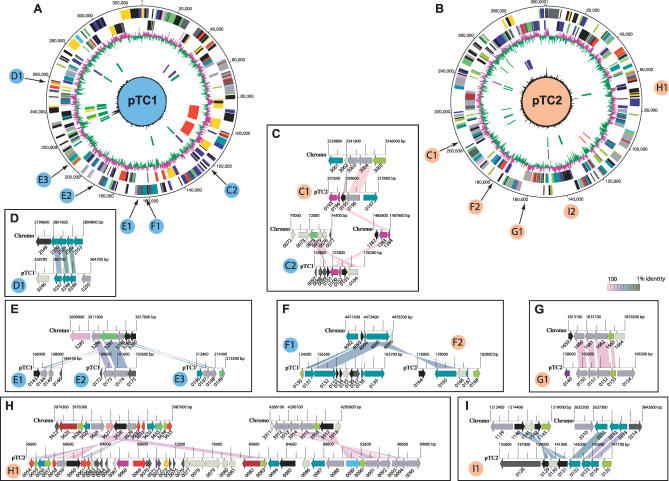
Circular Representations of the pTC1 and pTC2 Plasmids of A. aurescens TC1, and Comparative Linear Displays of Some of the Plasmid Regions Shared with the Strain TC1 Chromosome(A and B) Each concentric circle of the circular figures is numbered from the outermost circle to the innermost circle. For each plasmid, the first and second circles represent the predicted coding sequences on the plus and minus strands, respectively, colored by functional role categories (see Figure 1). The third circle displays the G + C skew: positive G + C skew in magenta and negative G + C skew in green. The fourth circle displays the repeated sequences of at least 50 bp long (at least 97% identity between two repeats); each color/tick size represents a different repeat. Prophage (blue ticks) and transposon (dark green ticks) genes are displayed on the fifth circle. The sixth circle shows the regions of atypical composition (χ2 analysis).(C–I) Comparative linear displays of some of the pTC1 and pTC2 sequences matching the TC1 chromosome. The percent of protein identity is indicated by the color of the connecting lines (legend on the right side of the figure). For clarity, the locus tags (AAur_ for the chromosome, and AAur_pTC1 and AAur_pTC2 for the pTC1 and pTC2 plasmids, respectively) were removed from the ORF numbers. For example, the chromosomal ORF number 2549 is AAur_2549, the pTC1 ORF number 0246 is AAur_pTC10246, and the pTC2 ORF number 0054 is AAur_pTC20054.